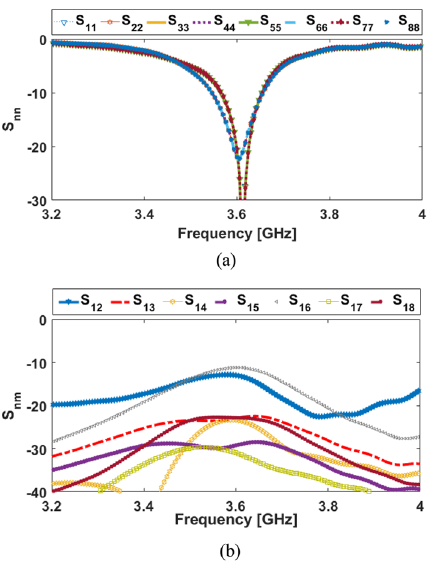
Figure 8. The simulated S-parameters for different elements: ( a ) S nn and ( b ) S nm .